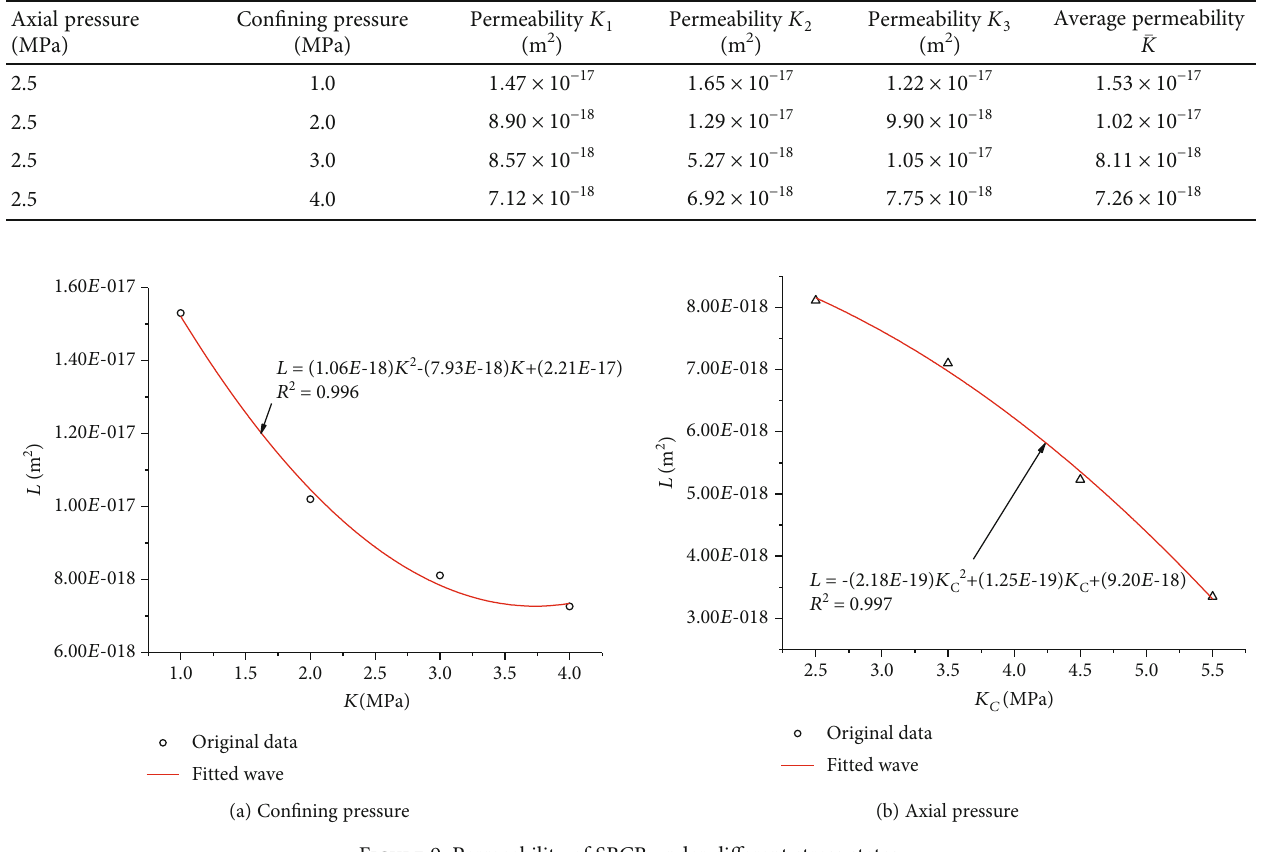
Figure 9: Permeability of SBCB under di ff erent stress states. Table 3: Results of permeability testing of the SBCB under di ff erent axial